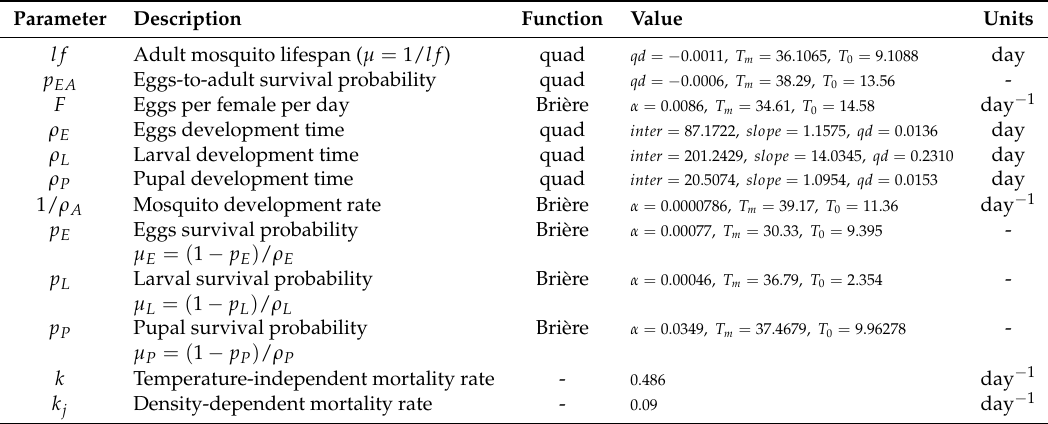
Table 1. Mosquito traits used across the three trait-dependent models explored. For each trait, we include the parameter, trait description, unimodal function assumed (for thermal traits), and the value of the trait or values of parameters of the curve. We provide the references and the curves associated with the temperature-dependent traits in Appendix